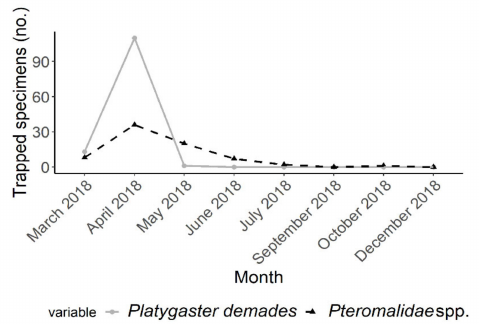
Figure 1. Number of trapped P. demades (Hymenoptera: Platygastridae) and Pteromalidae grouped by sampling date.